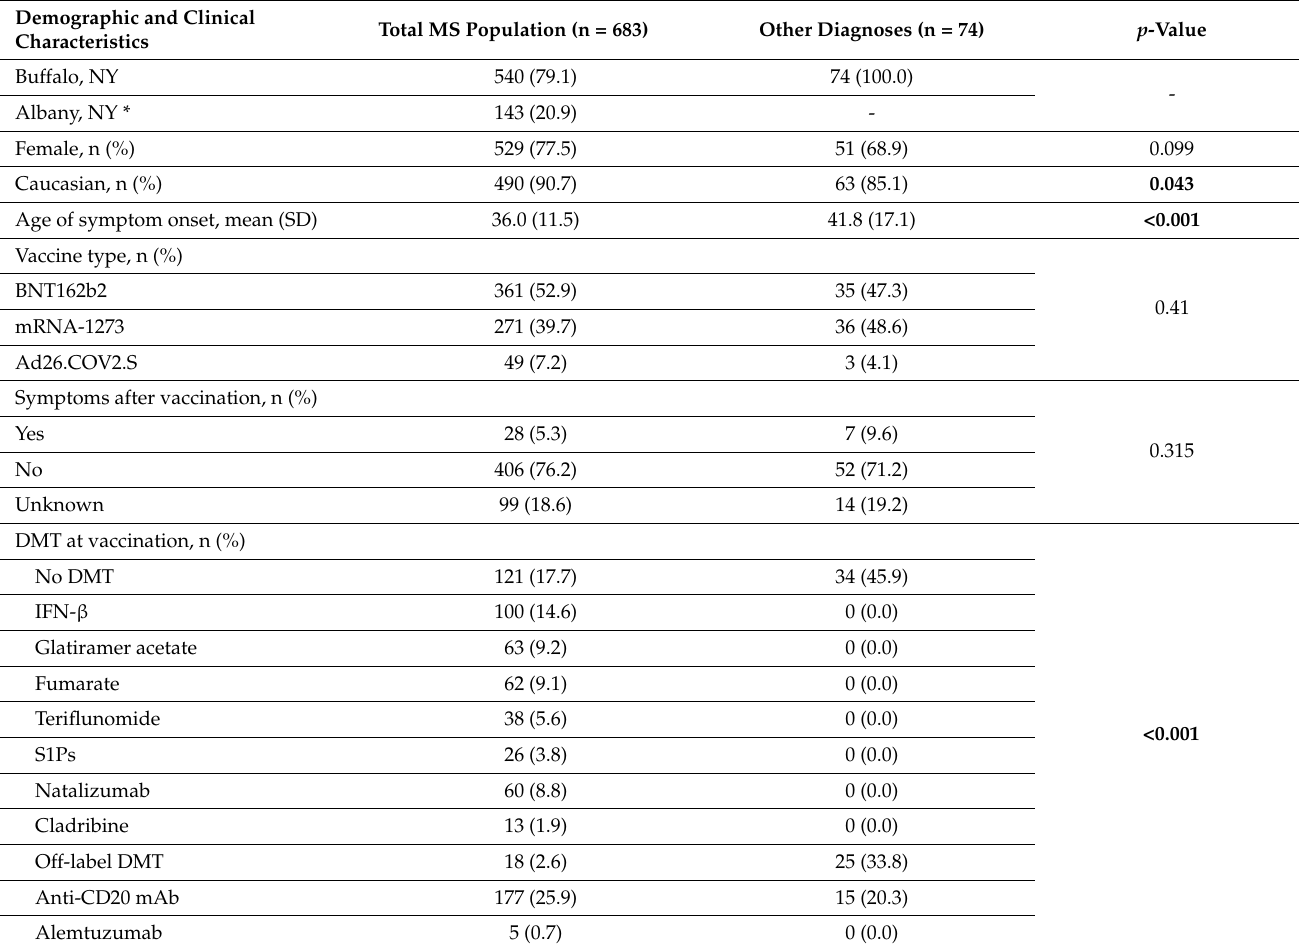
Table 1. Demographic and clinical characteristics of the study